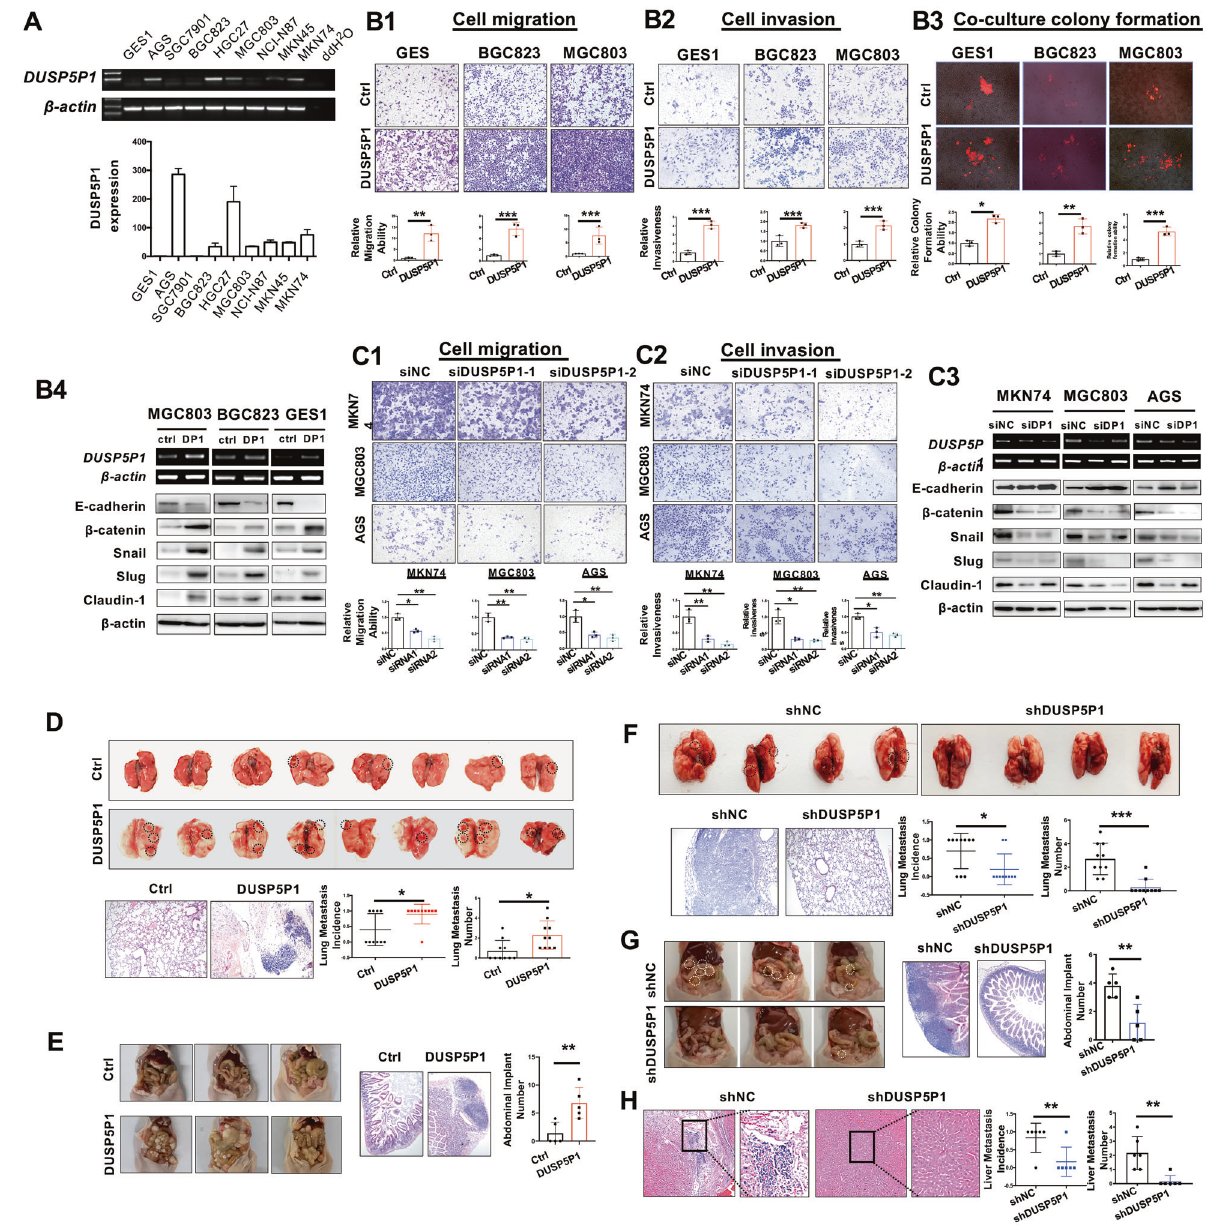
Fig. 2 DUSP5P1 promotes GC cell migration, invasion in vitro and metastasis in vivo. A DUSP5P1 was expressed in GC cell lines but not in the normal gastric cell line GES-1 by RT-PCR. B Representative images of migration and Matrigel invasion transwell assay revealed that ectopic expression of DUSP5P1 promoted cell migration (B1), cell invasion (B2) and RFP-tagged GC cell colonies in co-cultures with LO2(B3) in GES1, BGC823, and MGC803 cells, accompanied by enhanced protein levels of β -catenin, Snail, Slug and Claudin-1, and reduced level of E-cadherin (B4). C Representative images of migration and Matrigel invasion transwell assays revealed that knockdown of DUSP5P1 inhibited cell migration (C1) and invasion in MKN74, MGC803 and AGS cells (C2), accompanied by reduced protein levels of β -catenin, Snail, Slug and Claudin-1, and enhanced level of E-cadherin (C3). D Representative macroscopic appearance and histological con fi rmation by HE staining of lung metastasis of GC cells. DUSP5P1 expression in BGC823 cells signi fi cantly increased the number of metastatic lesions in the lungs. E Representative macroscopic appearances of peritoneal surfaces implanting and HE stained images injected with BGC823 cells transfected DUSP5P1 and control vector were shown. F Representative macroscopic appearances of lung metastasis and HE stained images of the lungs injected with MKN45 cells transfected shDUSP5P1 and shNC were shown. G Representative macroscopic appearances of peritoneal surfaces implanting and HE stained images injected with MKN45 cells transfected shDUSP5P1 and shNC were shown. H Representative HE stained images of the liver were shown. Silencing of DUSP5P1 in MKN45 cells signi fi cantly reduced the number of metastatic lesions in the liver. * P < 0.05, ** P < 0.01, *** P < 0.001, **** P <